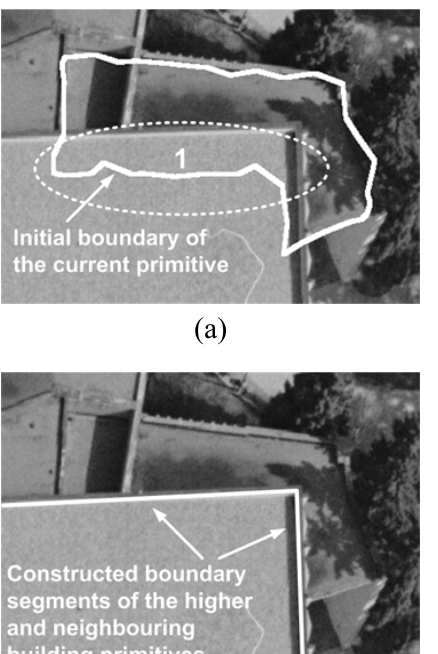
Figure 10. Relief displacement from higher and neighbouring building primitive in (a) left and (b) right warped images; (c) Constructed boundary segments of the higher and neighbouring building primitive; and (d) precise boundary segments for the current primitive after projection process and